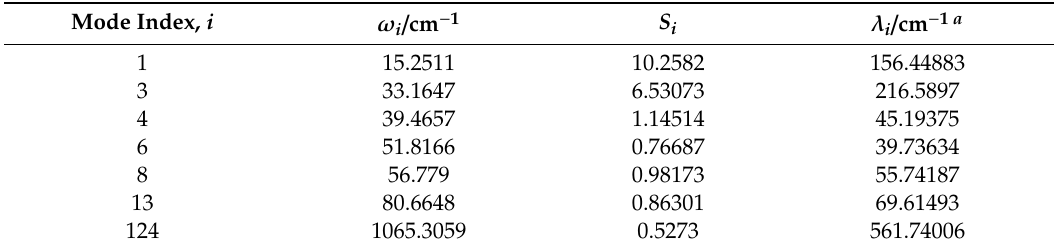
Table 5. Selected Huang–Rhys factors and the corresponding normal